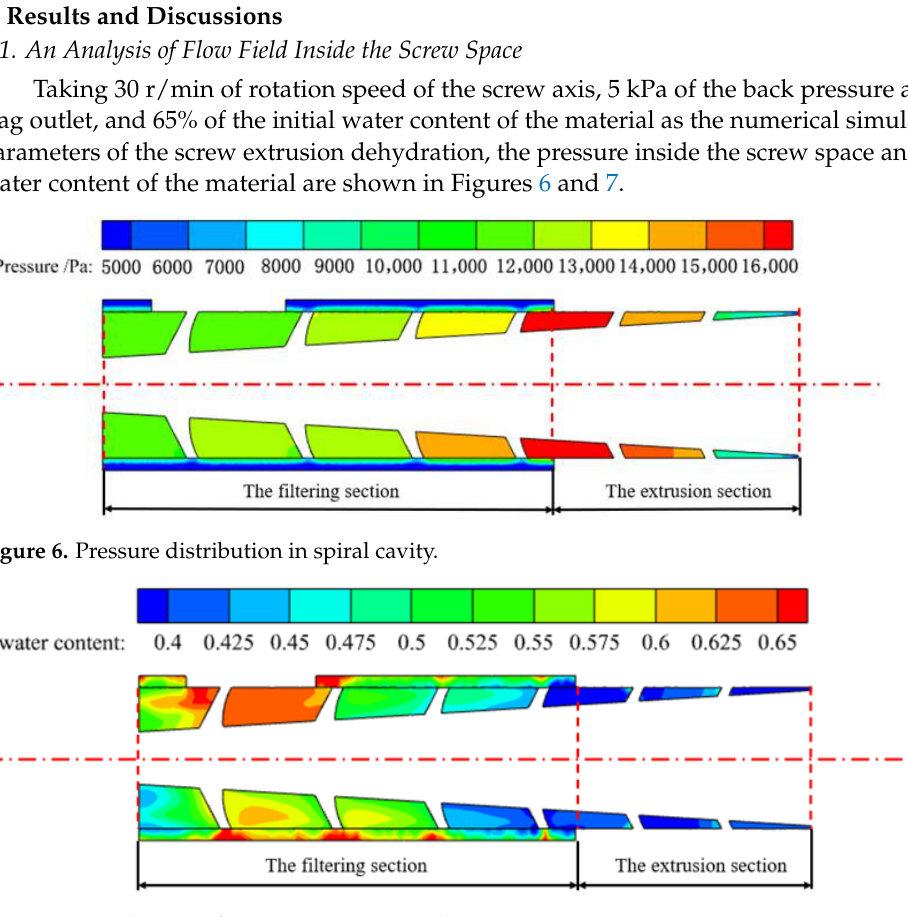
Figure 7. Distribution of water content in spiral cavity.